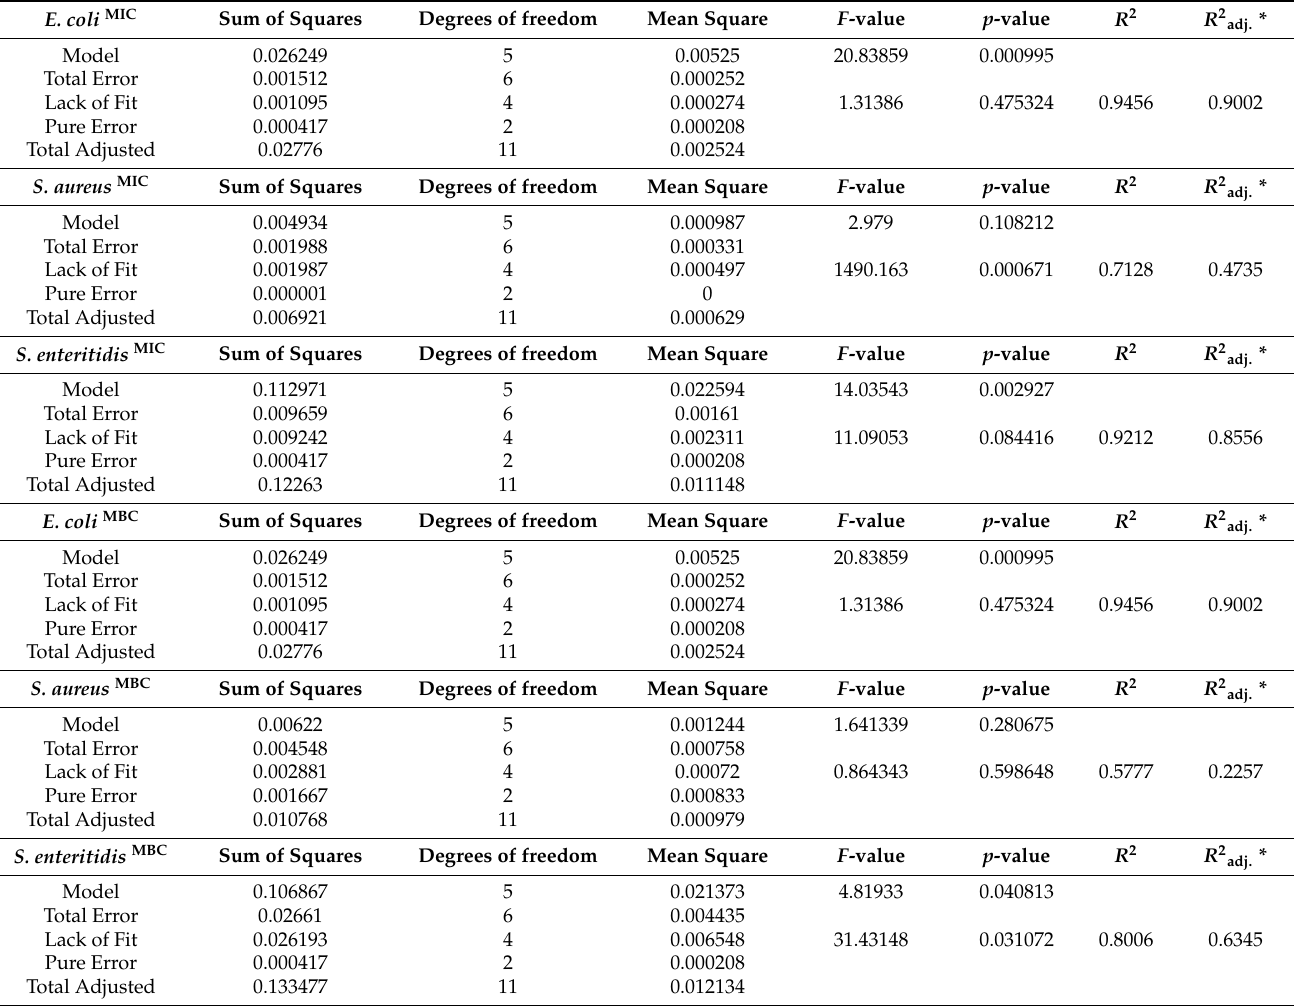
Table 1. The quality of the quadratic model through analysis of variance (ANOVA) for the mini- mum inhibitory concentration (MIC) and minimum bactericidal concentration (MBC) experiments concerning essential oils (EOs) against Escherichia coli , Staphylococcus aureus , and Salmonella enterica serotype